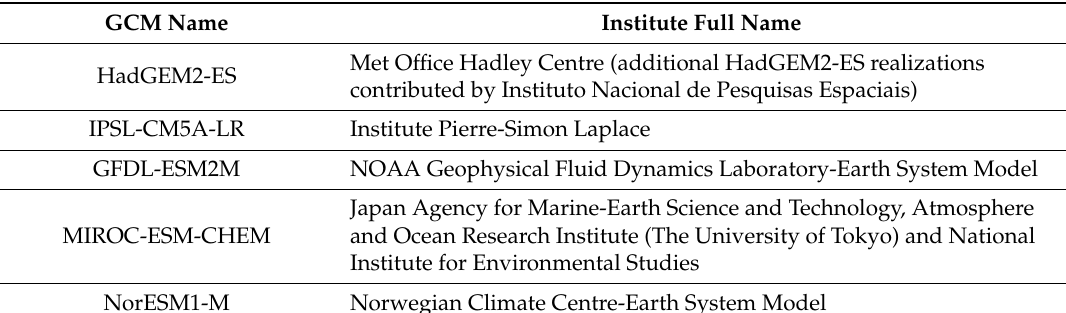
Table 1. Description of the five Global Circulation Models (GCMs) used in this study obtained from Coupled Model Intercomparison Project